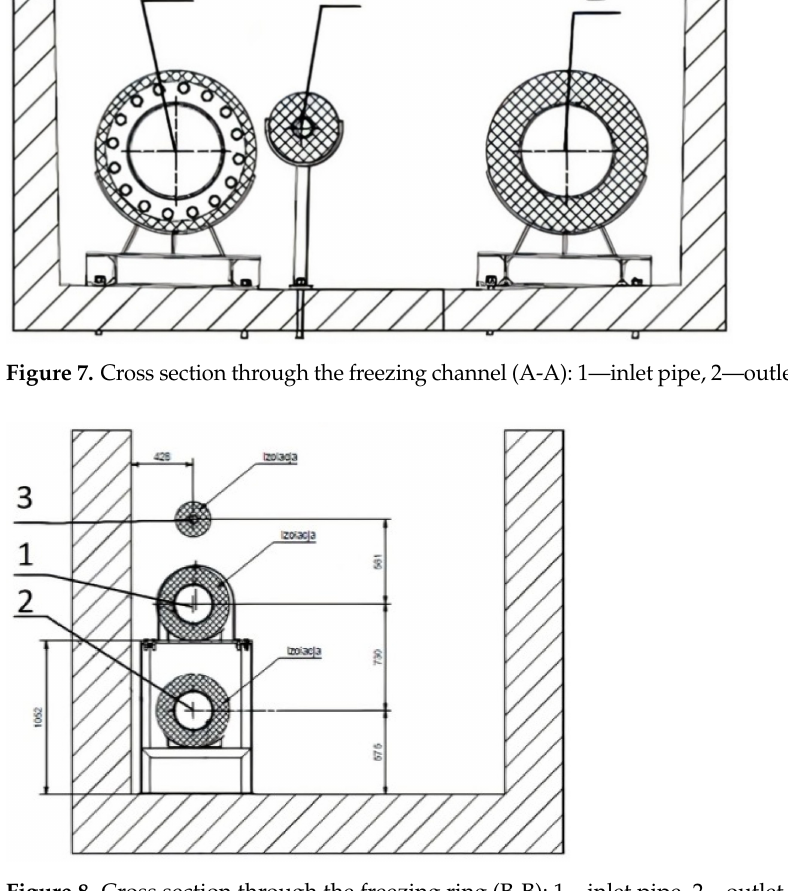
Figure 8. Cross section through the freezing ring (B-B): 1—inlet pipe, 2—outlet pipe, 3—vent